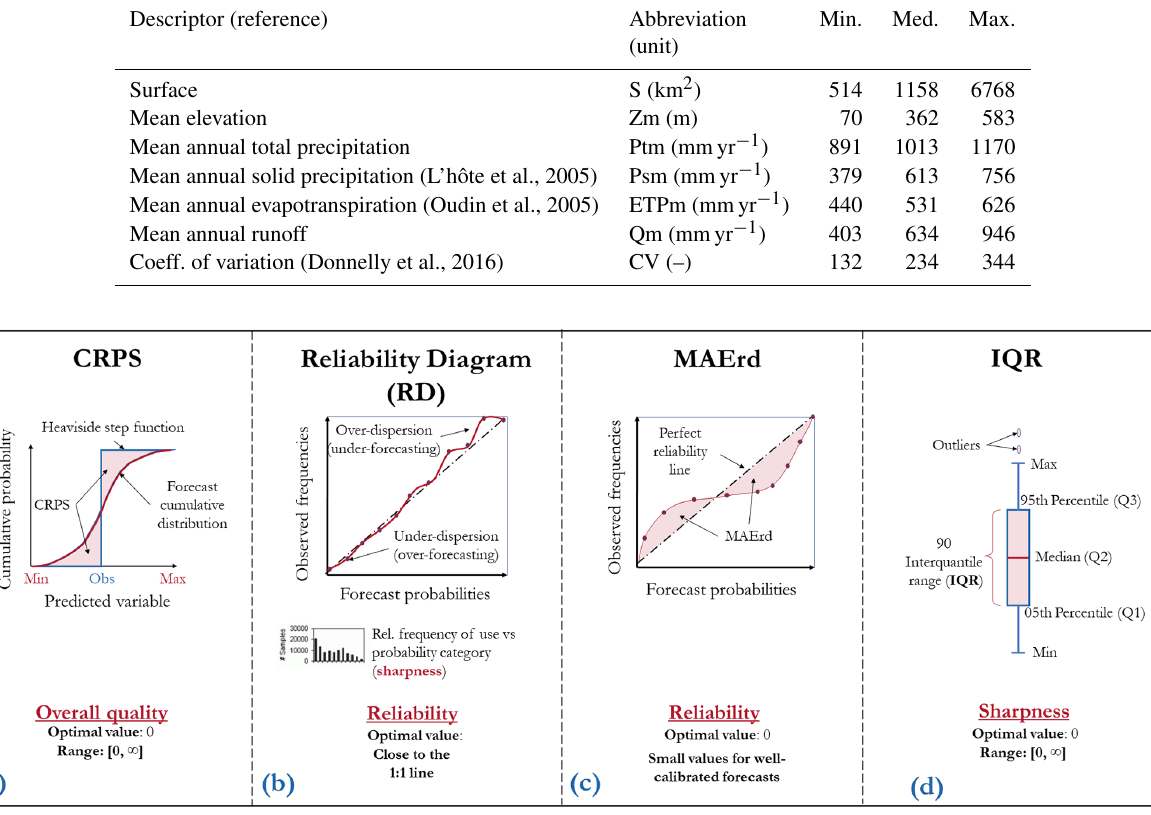
Figure 3. Graphical representation of the CRPS, reliability diagram, MAE of the reliability diagram (MAE rd ), and IQR forecast evaluation